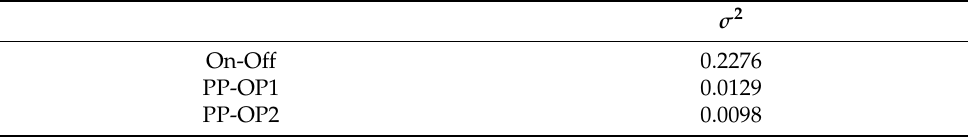
Table 2. Control signal variance ( σ 2